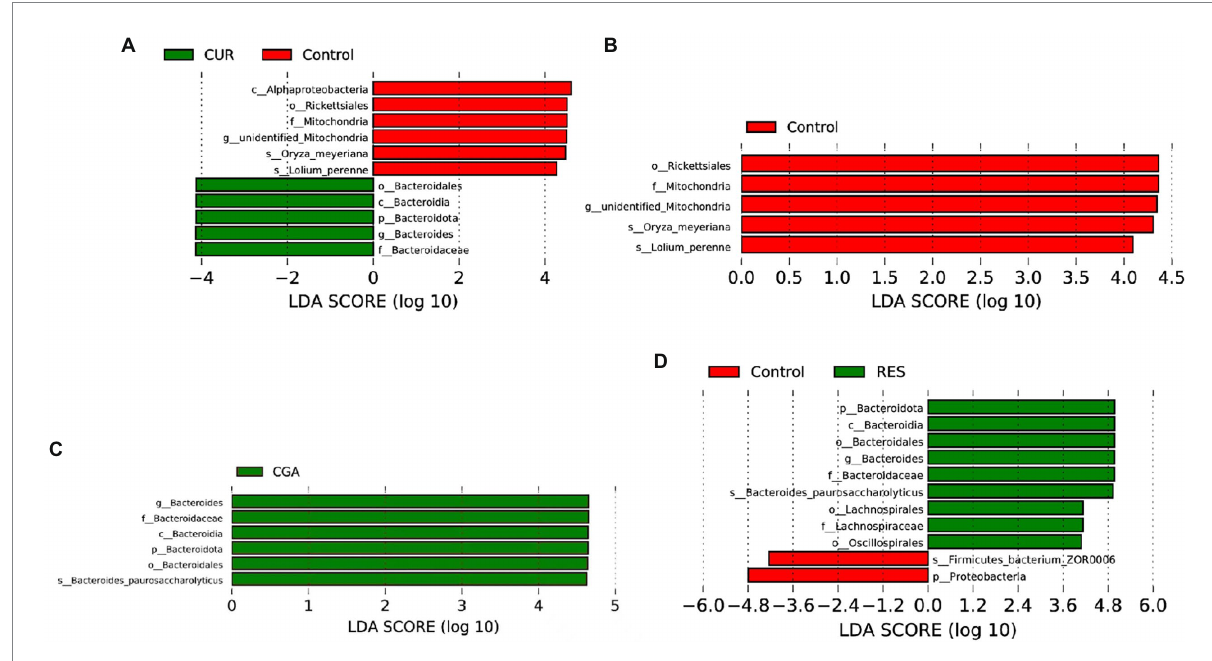
FIGURE 8 Differentially represented bacteria by LEfSe between (A) CUR and control; (B) OPC and control; (C) CGA and control; (D) RES and control ( n = 9 per treatment). CON, control group; CUR, curcumin group; OPC, oligomeric proantho cyanidins group; CGA, chlorogenic acid group; RES, resveratrol group.